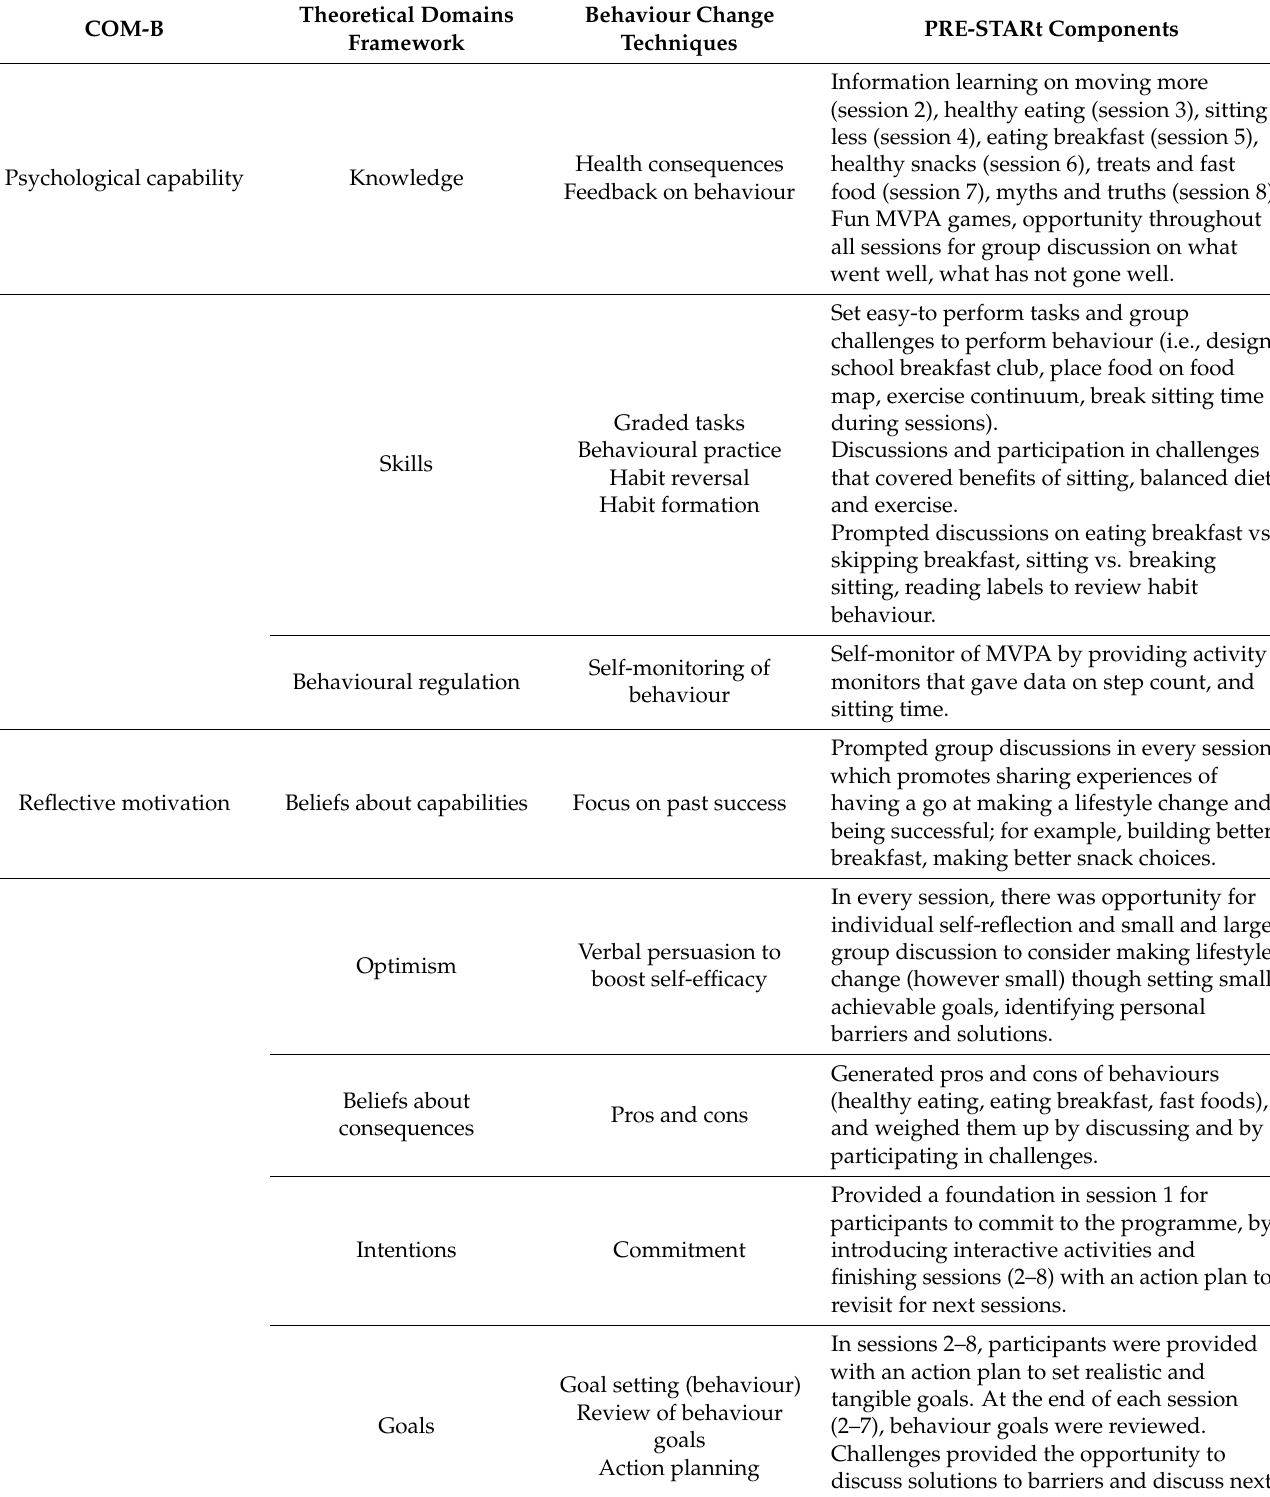
Table 2. COM-B (capability, opportunity, motivation behaviour) theoretical framework for the PRE-STARt